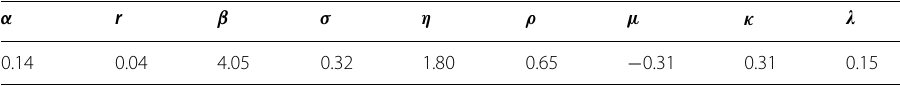
Table 2 Parameter values for our numerical example α r β